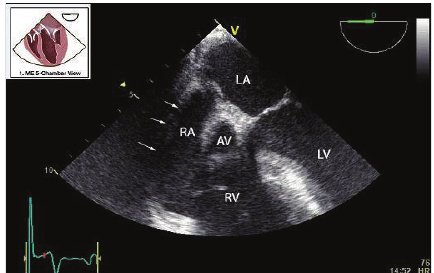
Figure2:Midesophageal(ME)five-chamberview.Arrowsdelineate the lateral wall of the right atrium (RA) (see Supplemental Digital Content 1 for the associated video in the Supplementary Material available online at http://dx.doi.org/10.1155/2015/136595). A mass of echogenic pattern consistent with hepatic tissue is visualized adjacent to and compressing the RA. Cartoon inset = ME 5-chamber view adapted from ASE and SCA Guidelines and Standards [7]. AV: aorticvalve,LA:leftatrium,LV:leftventricle,andRV:rightventricle.